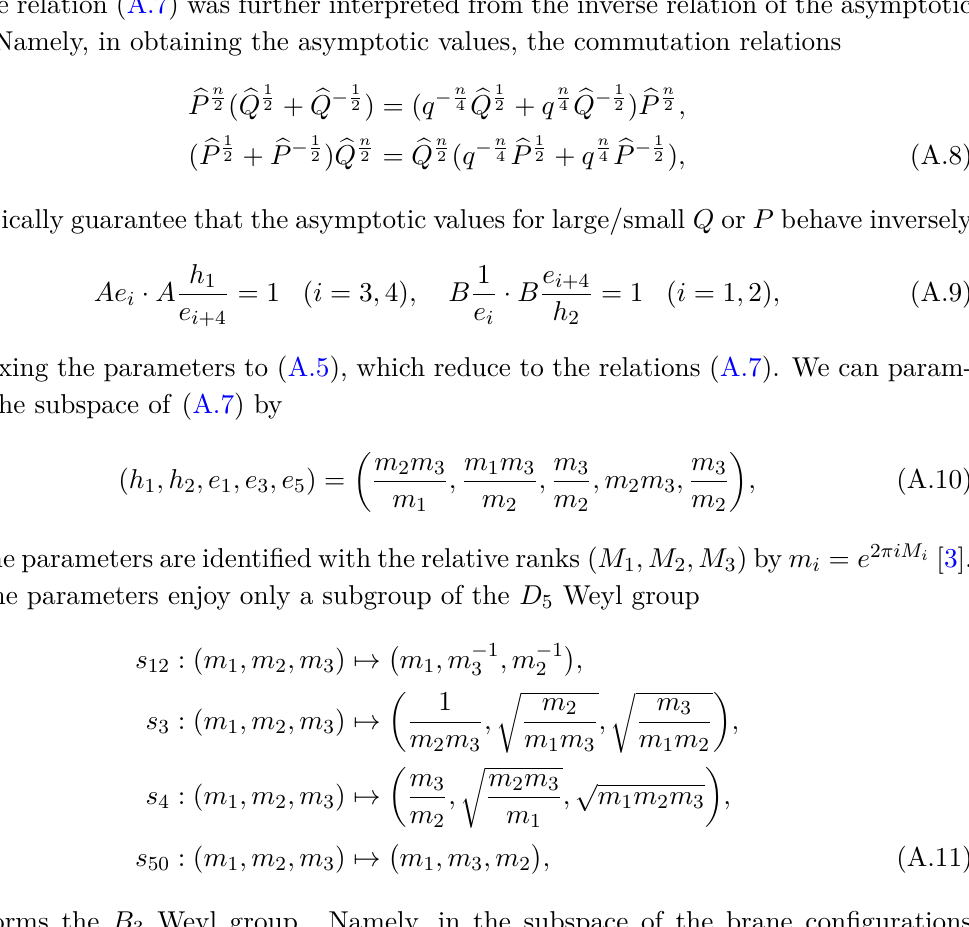
= s and s = s remain as symmetries. 12 1 s 2 50 5 s 0